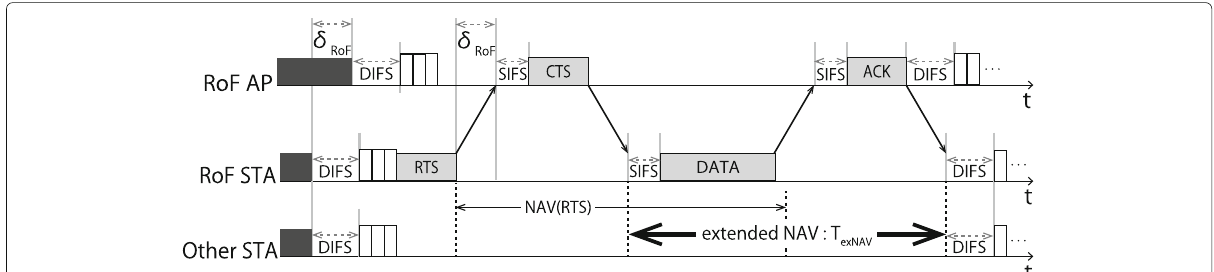
Fig. 5 NAV extension method in an RoF-based WLAN. A CTS frame transmitted by the RoF AP extends NAV at